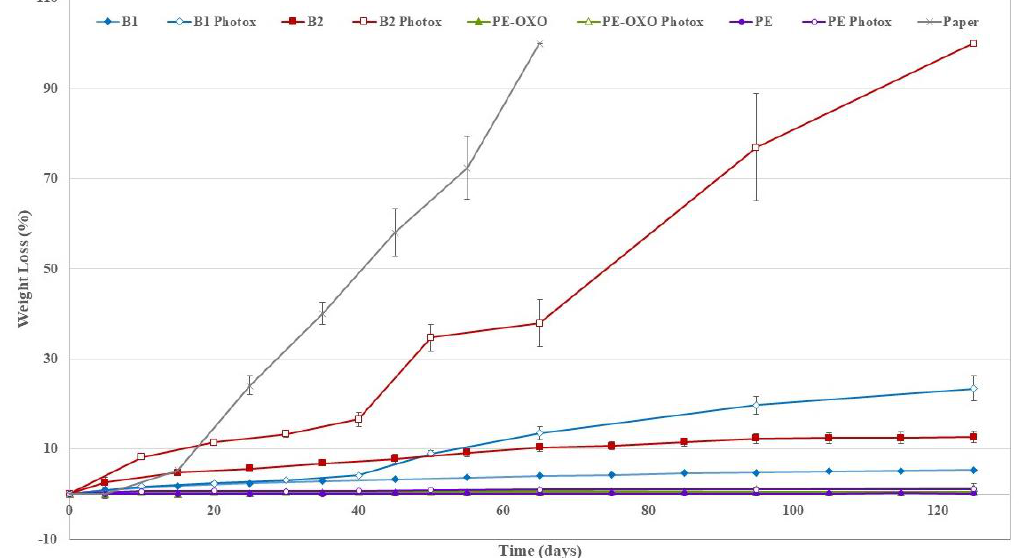
Figure 3. Average weight loss values (%) vs. degradation time for all the film samples—virgin and photo-oxidized.